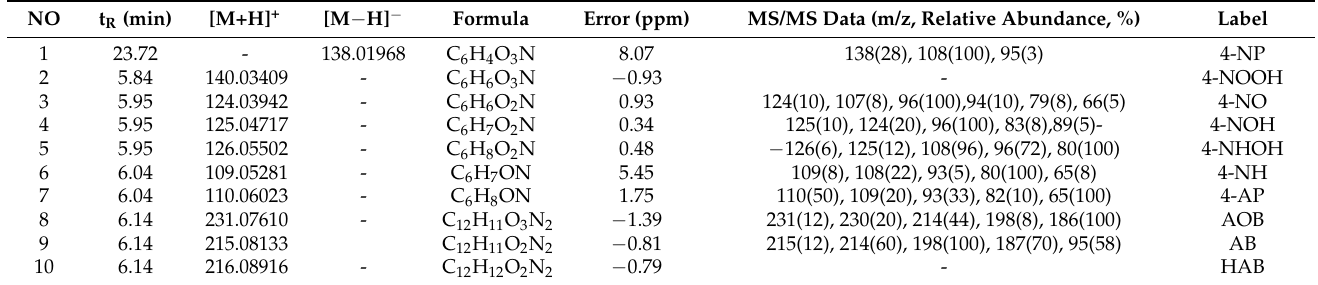
Table 1. Identification of compounds in the reaction system by